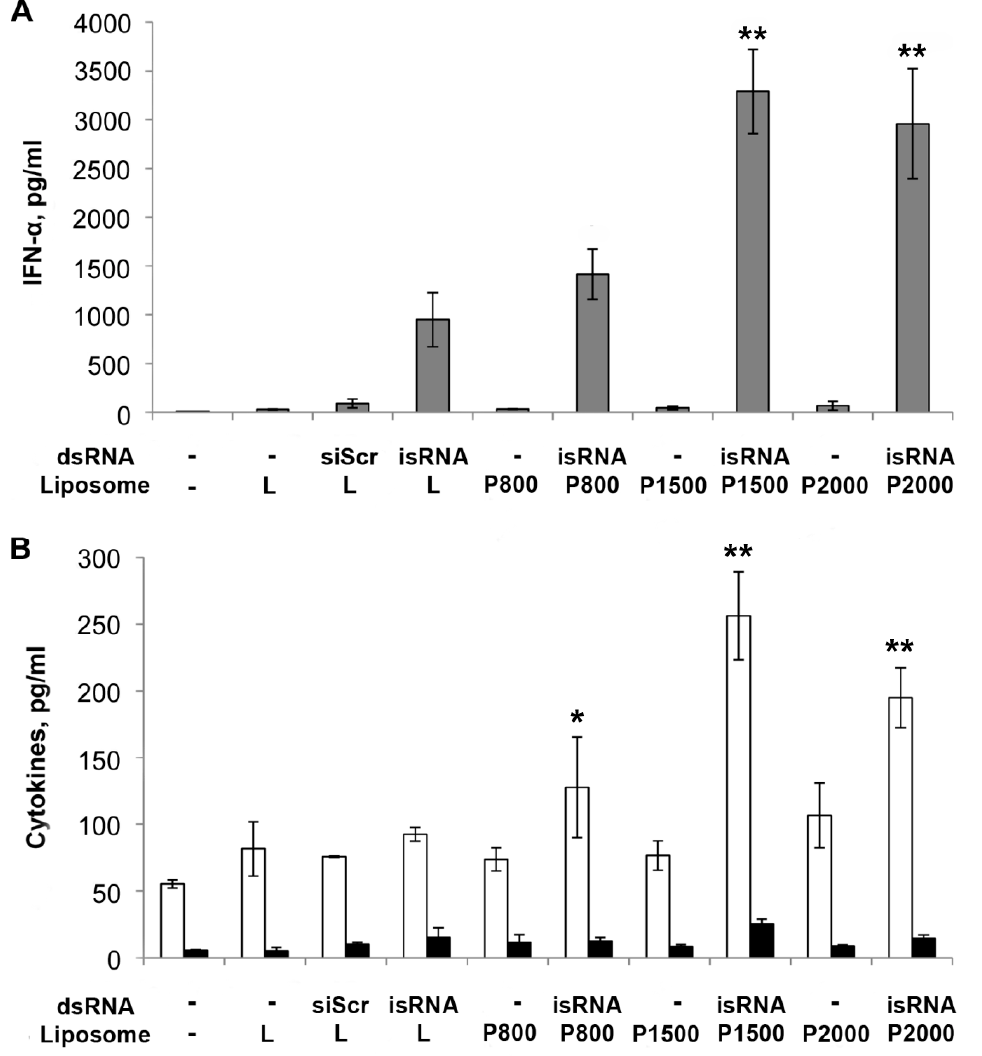
Figure 6. Stimulation of the innate immune response by isRNA in complexes with PEGylated P and conventional L liposomes in vivo. CBA/LacSto mice were injected i.v. with isRNA (10 µ g per mouse) in complex with liposomes (at the ratio N/P = 4/1). siRNA with scrambled sequence (siScr) was used as a control. ( A ) Serum IFN- α and ( B ) IL-6 (white columns) and TNF- α (black columns) levels were measured by ELISA 6 h after injection. The data represent means ± standard deviation (SD) calculated from measurements from at least three mice. The differences between mean values for isRNA/ L and other preparations were considered statistically significant: * p < 0.05, ** p < 0.01 (Mann-Whitney